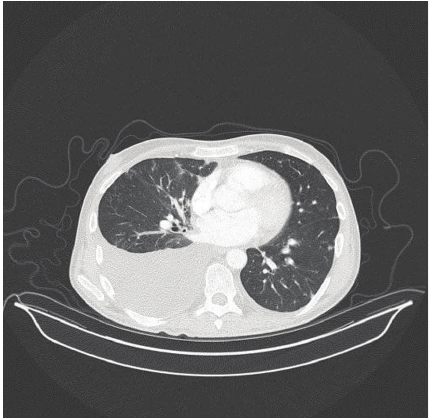
Figure 2: CT examination confirmed a unilateral right pleural effusion and small lung nodules (transverse computed tomographic image of patient’s chest demonstrating posterior right chest effu- sion).